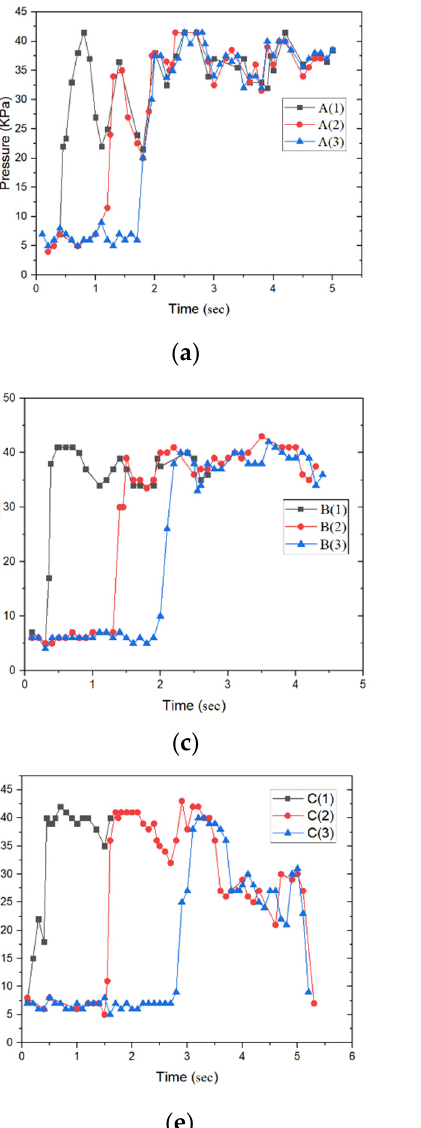
( b ) Figure 32 . Movement speed of the robots in di ff erent cabins: ( a ) Di ff erent types of robots vary in speed at di ff erent positions; ( b ) Acceleration and resistance for di ff erent types of robots. As shown in the fi gure, the speed of the dual-cabin section robot was 0.893 m/s when it passed the third sensor, and the speed reduced to 0.57 m/s when it passed the fi fth sen- sor after 1.7 s. The acceleration was − 1.19 m/ s (cid:2870) , and the resistance was 54.26 N. The whole movement process was slow compared to the single-section pipeline robot. Experiments have shown that, as the number of compartments increases, the robot mass increases, while the front and rear compartments generate reaction forces under the action of the coupling. Therefore, its motion is slow, and the resistance is greater. 5. Conclusions